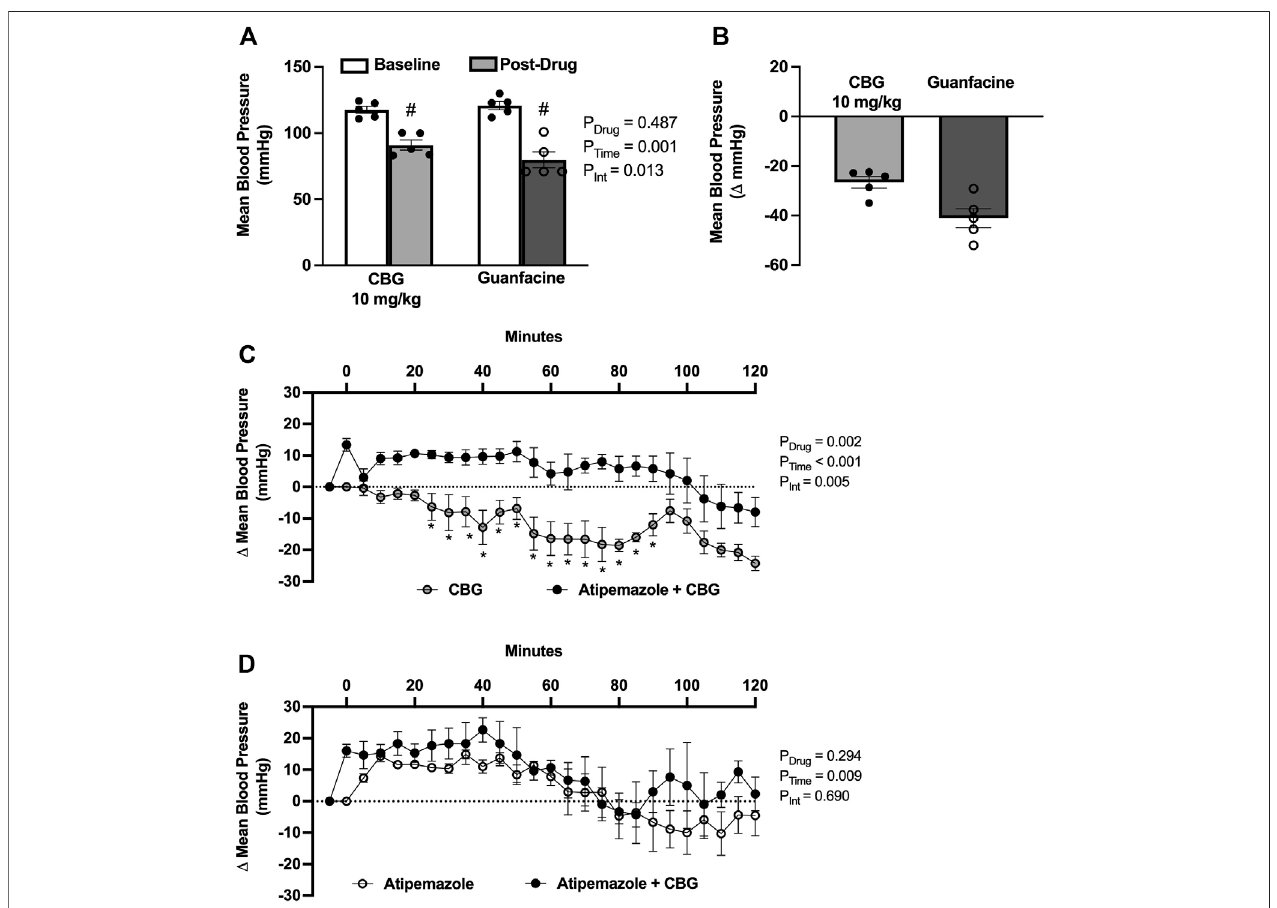
FIGURE 2 | Acute cannabigerol (CBG) lowers blood pressured via an alpha2-adrenoreceptor ( α 2AR) mechanism. (A) CBG (10 mg/kg, i.p.) lowered mean blood pressure to a lesser extent than guanfacine (1 mg/kg, i.p.) administration (P Drug = 0.487, P Time = 0.001, P Int = 0.013; two-way repeated measures ANOVA; # p < 0.01 versusbaselinefollowingposthoc Š ídák ’ smultiplecomparisonstest;N=5/group). (B) ThemagnitudeofdepressoreffectofCBGwaslessthanguanfacinewhenshown asthepeakchangefrombaseline( − 27±2 vs . − 41±4 mmHg,respectively). (C) Pretreatmentwiththe α 2ARantagonistatipamezole(3 mg/kg,i.p.)preventedCBG (10 mg/kg, i.p.) blood pressure lowering effects (P Drug = 0.001, P Time < 0.001, P Int = 0.001; two-way repeated measures ANOVA; * p < 0.05 versus atipamezole + CBG following post hoc Š ídák ’ s multiple comparisons tests; N = 5/group). (D) There were no signi fi cant differences in the blood pressure effects of atipamezole versus atipamezole plus CBG (P Drug = 0.294, P Time < 0.001, P Int = 0.690; two-way repeated measures ANOVA; N =